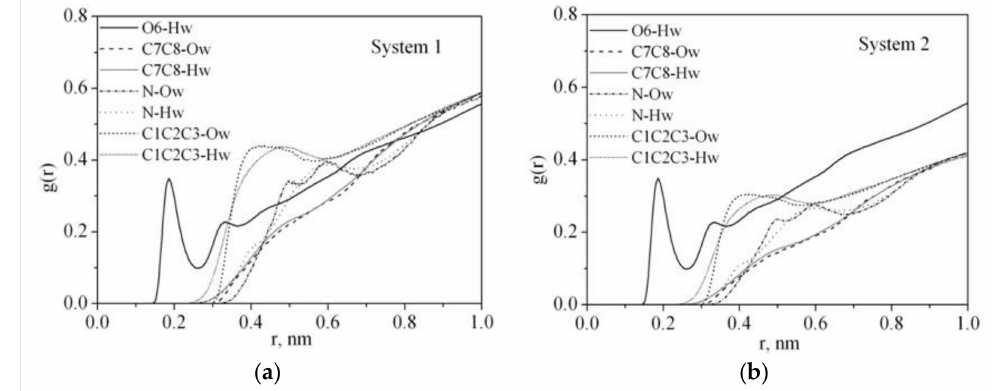
Figure 5. Atom–atom radial distribution functions for PVP in water: ( a ) system 1, ( b ) system 2.